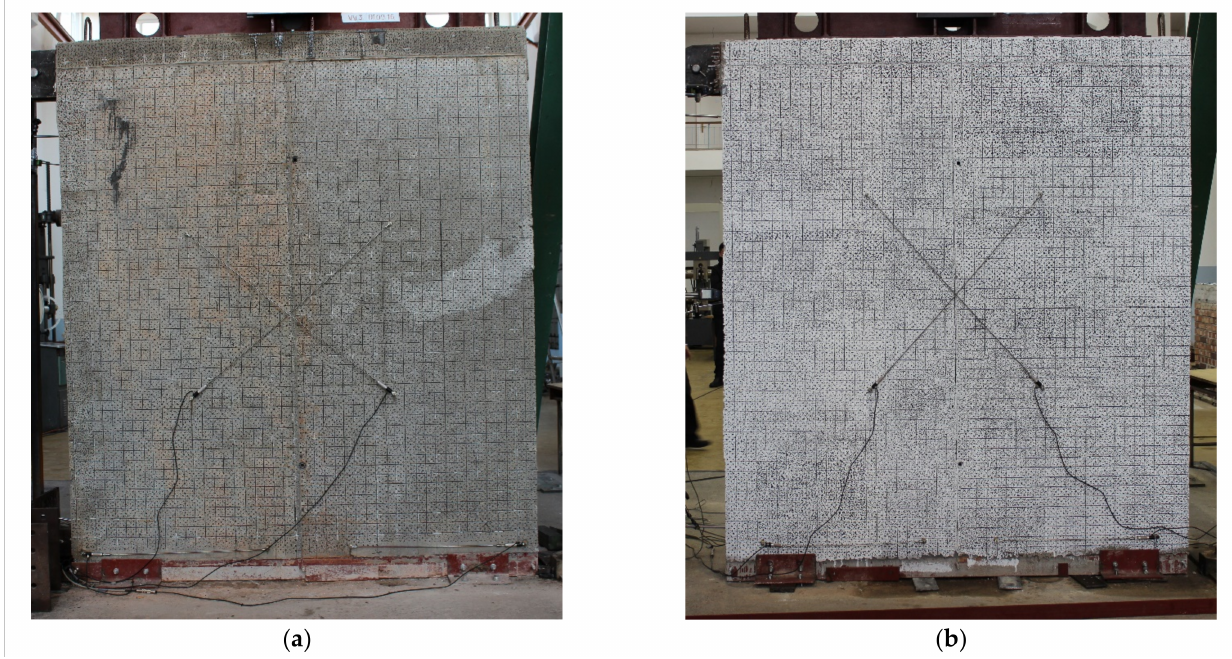
Figure 16. Jacketed walls: ( a ) W3; ( b )